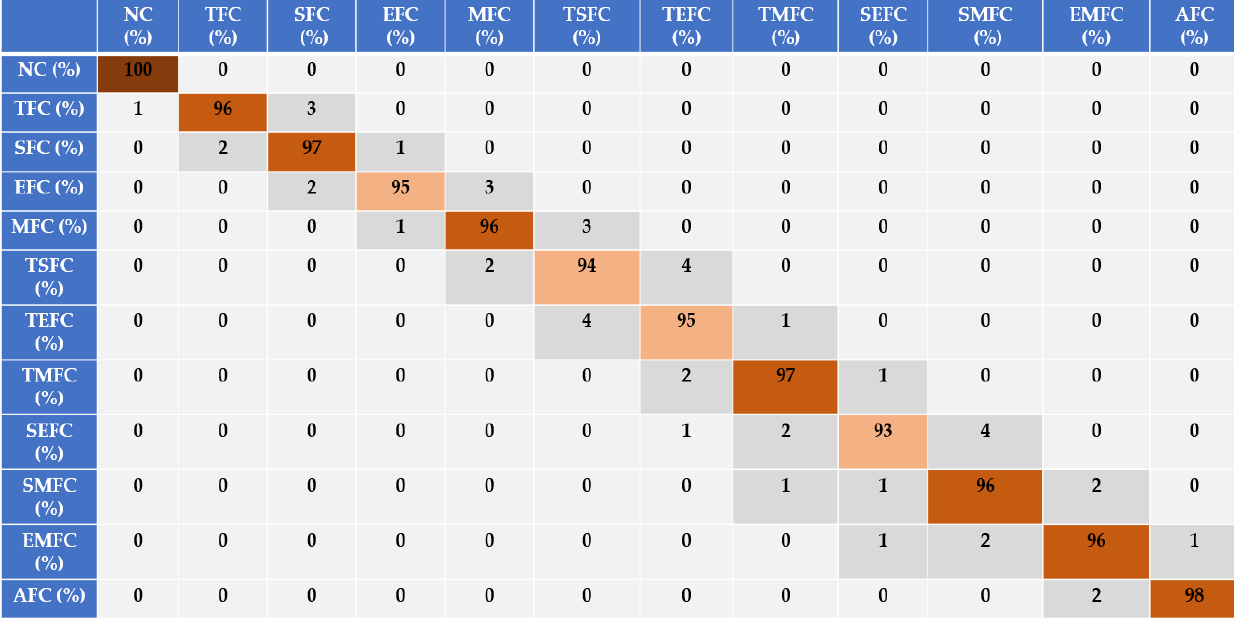
Figure 11. Sensor-fault-classification accuracy using FGAL-LCR and an SVM.